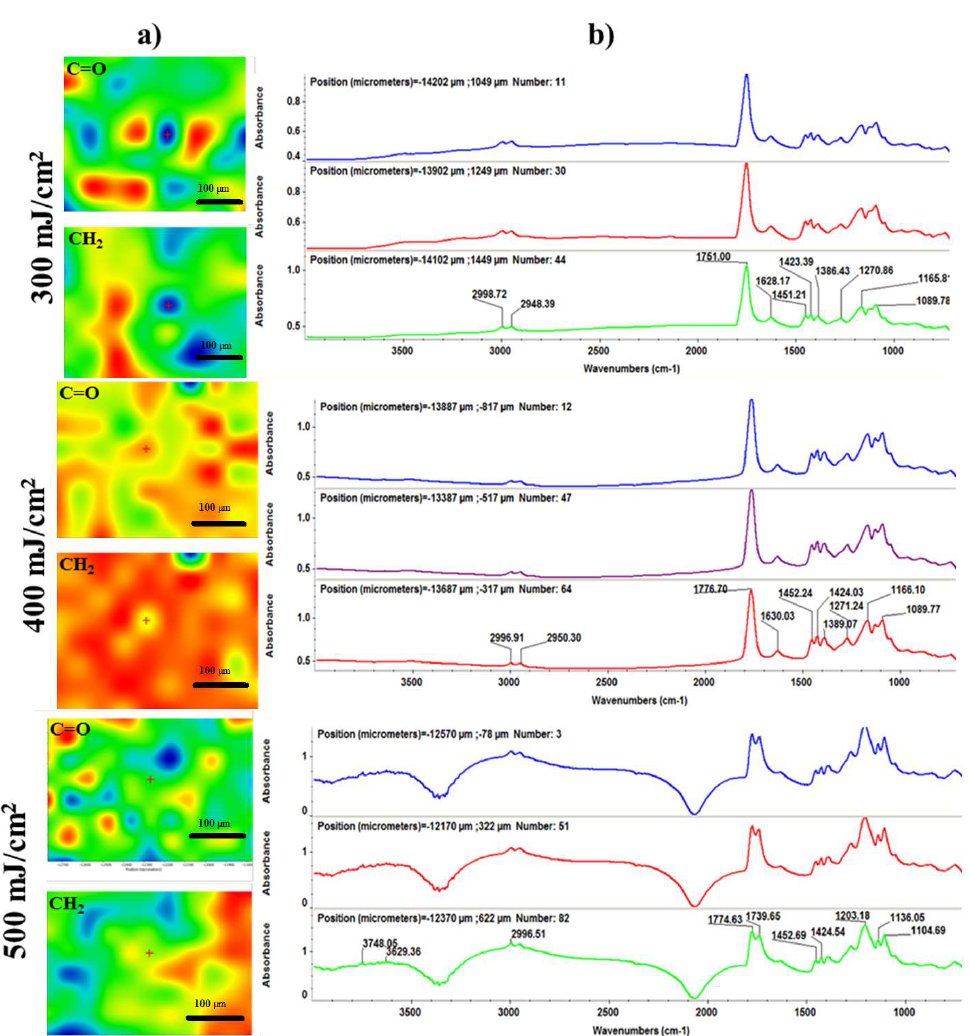
Figure 5. Infrared micrographs ( a ) and corresponding infrared spectra ( b ) of PLGA/Fe 3 O 4 @CEF dropcast coating.